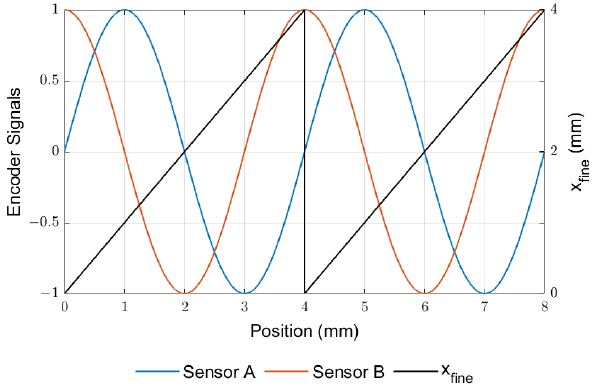
Figure 5. Ideal signals from sensor channels A and B of a sine–cosine